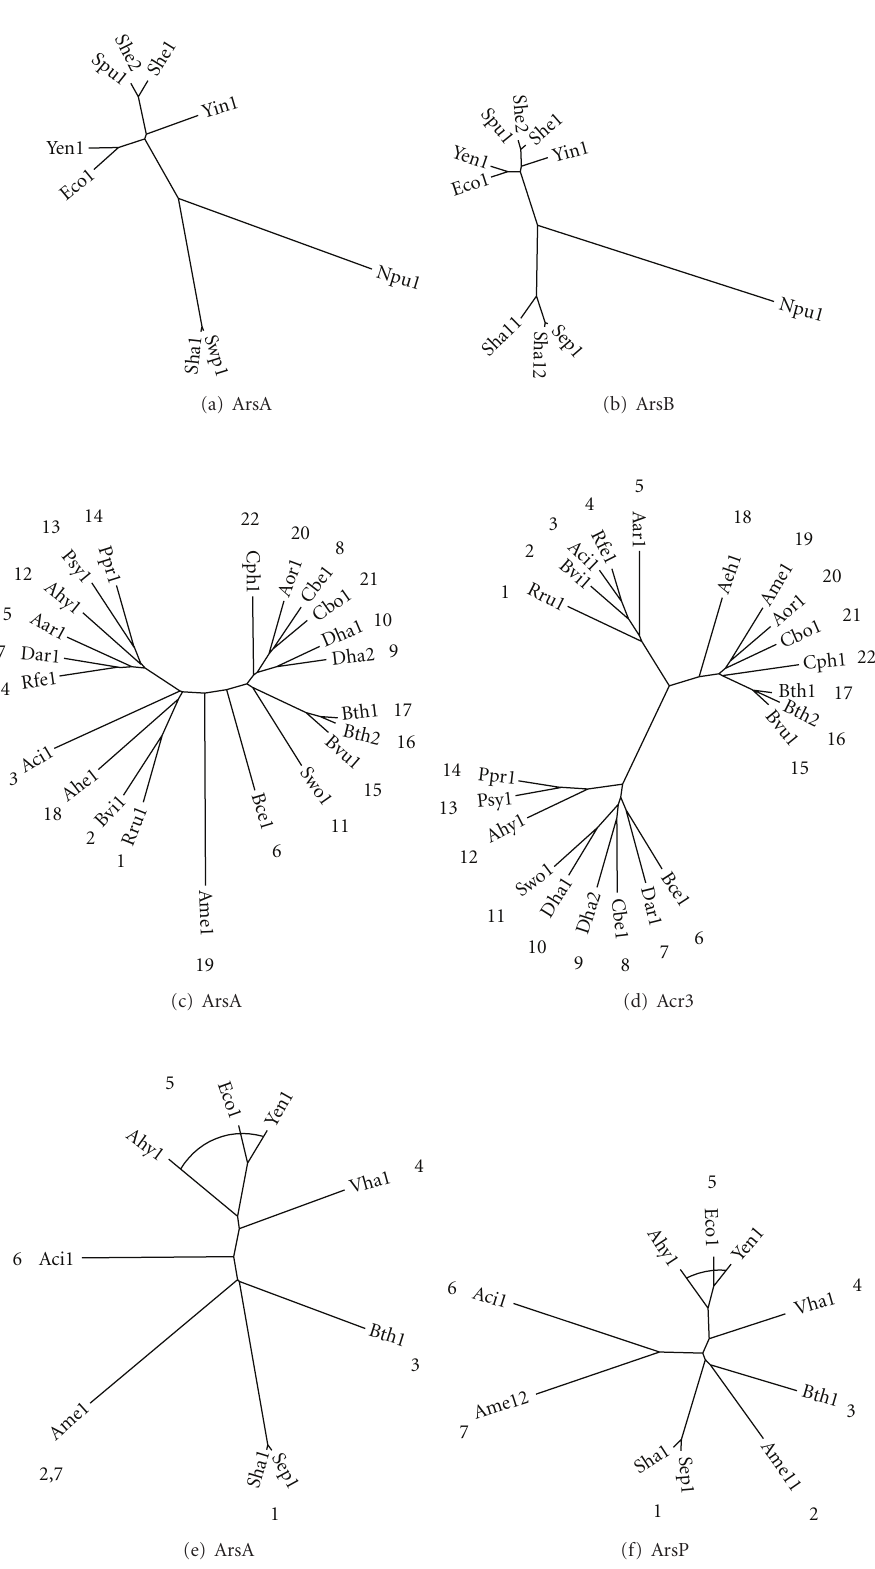
Figure 3: Phylogenetic trees showing the coevolution of (a) ArsA and (b) ArsB homologues, (c) ArsA and (d) Acr3 homologues, and (e) ArsA and (f) ArsP homologues, each pair encoded within the same operons. Numbers are assigned in (d) and retained in (c). Numbers are assigned counterclockwise in (f) and retained in (e). Paralogues are distinguished with a second digit, either 1 or 2, in the protein abbreviations. gi numbers are provided in Table